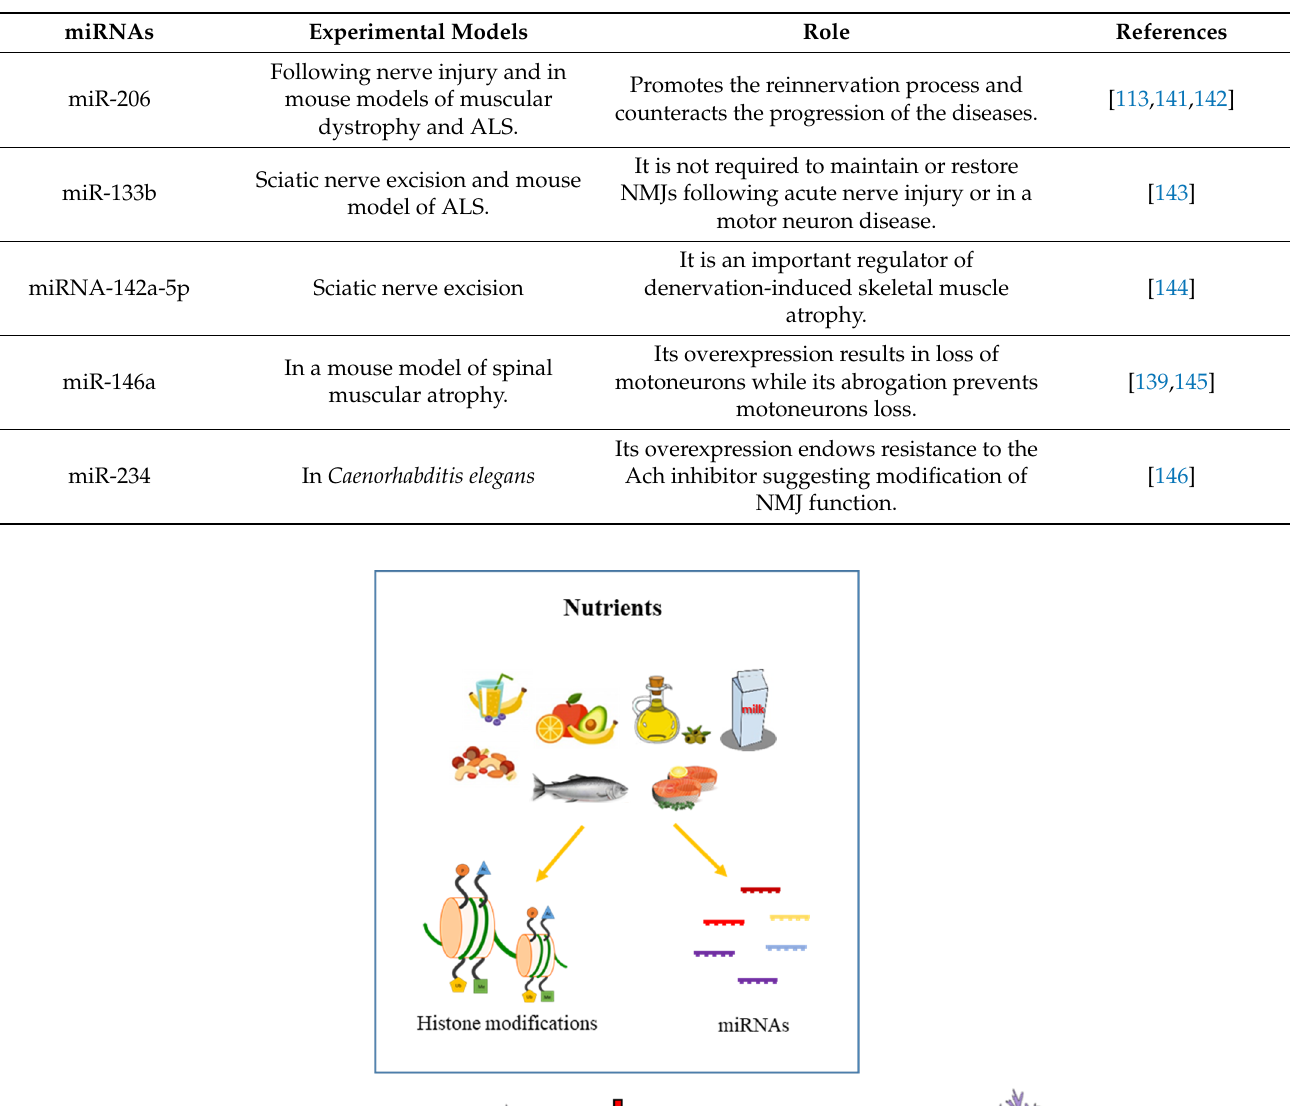
Table 1. Table showing some of the miRNAs involved in aging and/or neurodegenerative diseases.